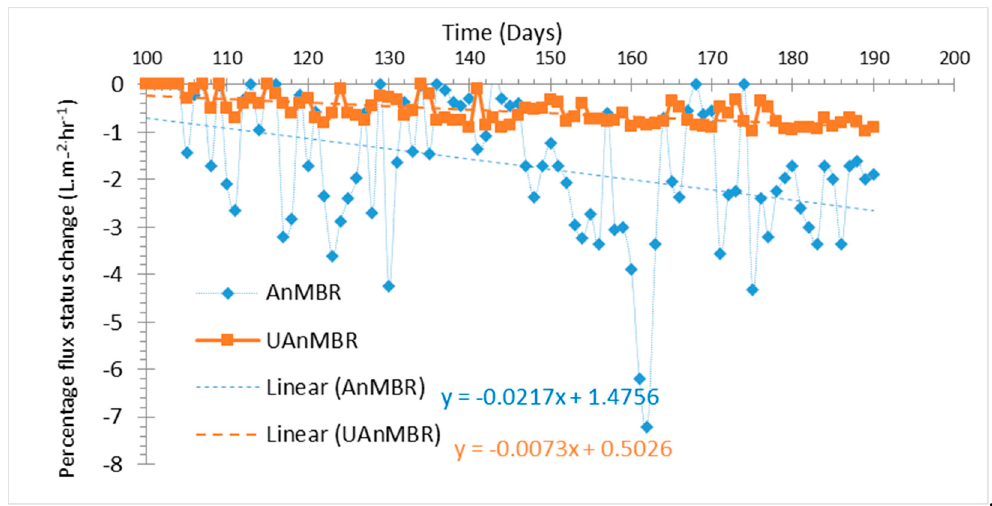
Figure 7. Percentage flux reduction in AnMBR and UAnMBR from the 100th (new membrane installed) to the 190th day.